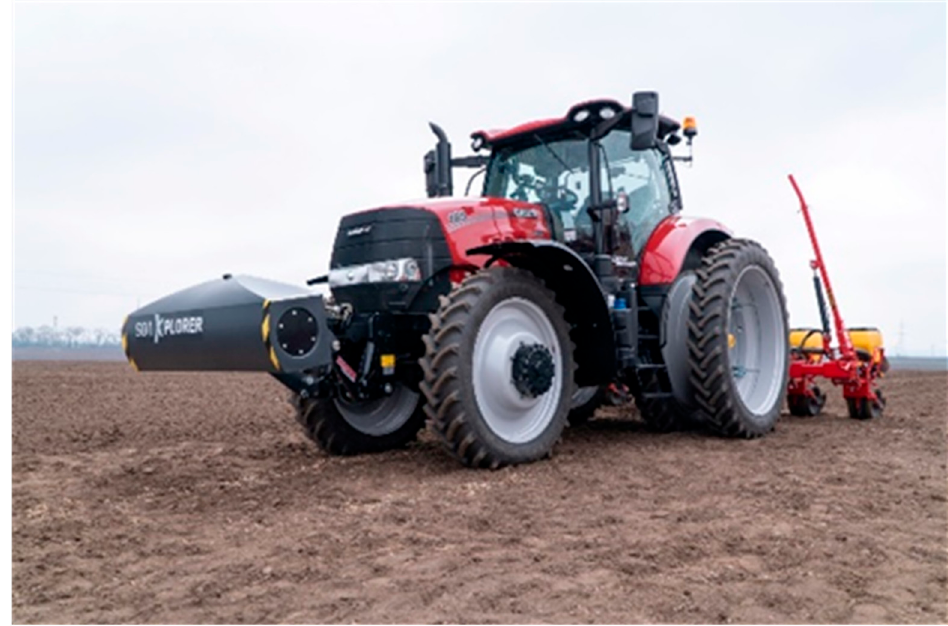
Figure 12. SoilXplorer device for measuring soil structure differences [60].